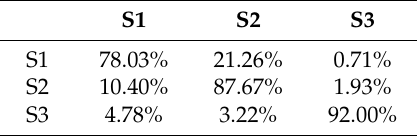
Table 6. PLS predictions for the propranolol set. Confusion matrix for dosages of propranolol prediction. D0